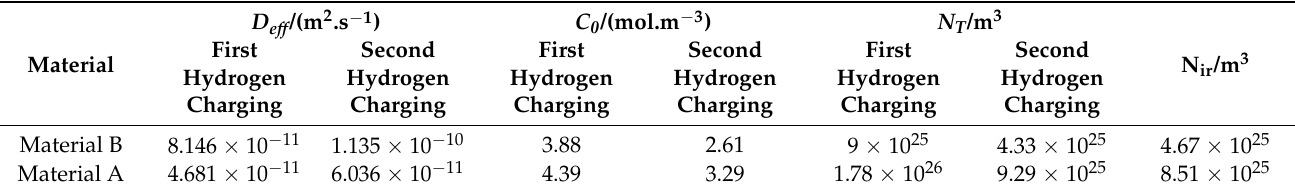
Table 3. Calculation results of hydrogen diffusion parameters. Material